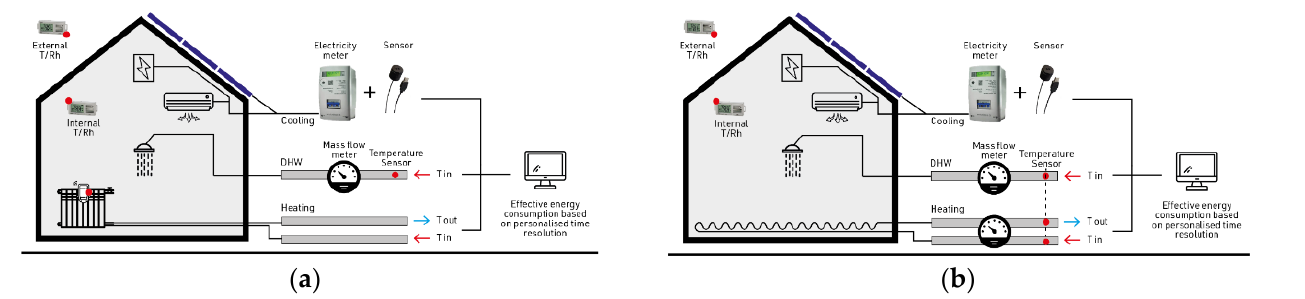
Figure 4. Advanced level: ( a ) Configuration 4a: dwelling with centralized domestic hot water and heating (radiators) production; ( b ) Configuration 4b: dwelling with centralized domestic hot water and heating (heated floors) production. Source: elaborated by authors.